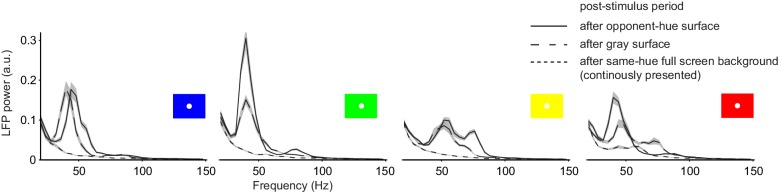
LFP power spectra for the post-stimulus period for the four chromatic background hues (3.5–3.8 s, excluding the initial transient response after stimulus offset at 3.3 s).Clear gamma-band responses were observed for full-screen surfaces after both gray and opponent-hue surface presentation in the stimulus period.